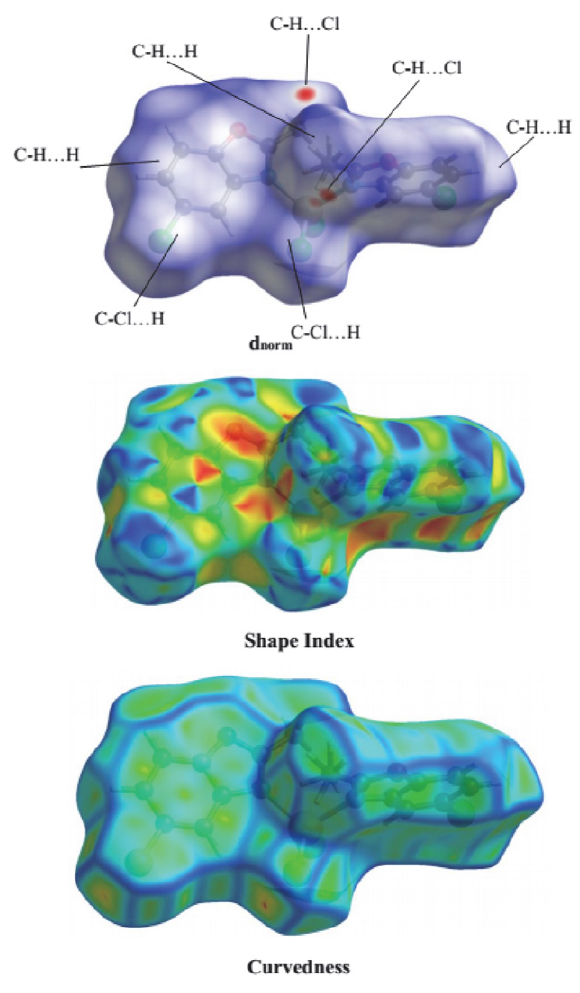
Figure 5: Hirshfeld surfaces mapped with d norm , shape index, and curvedness of zinc(II)